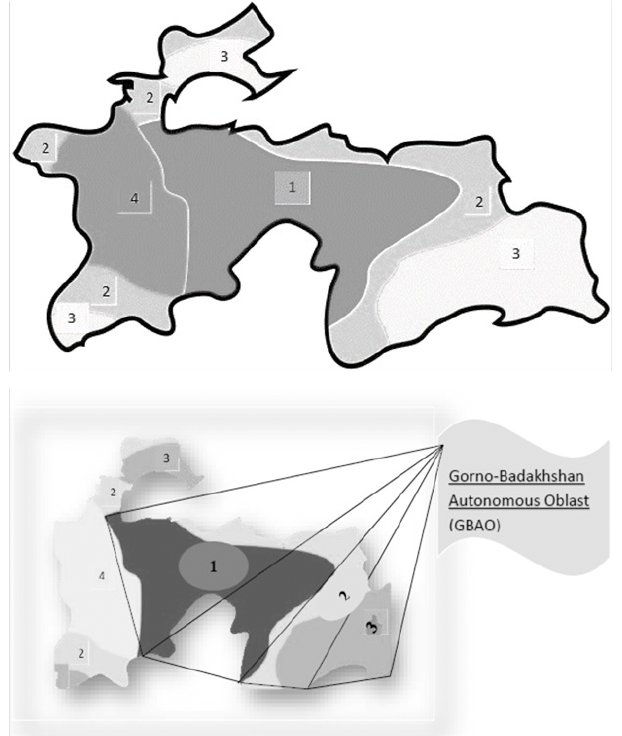
Figure 4. Climatic zones of the Republic of Tajikistan and Gorno Badakhshan Autonomous Oblast: 1 – warm continental climate; 2 – cold semi-arid climate; 3 – dry cold climate; 4 – warm Mediter- ranean climate.